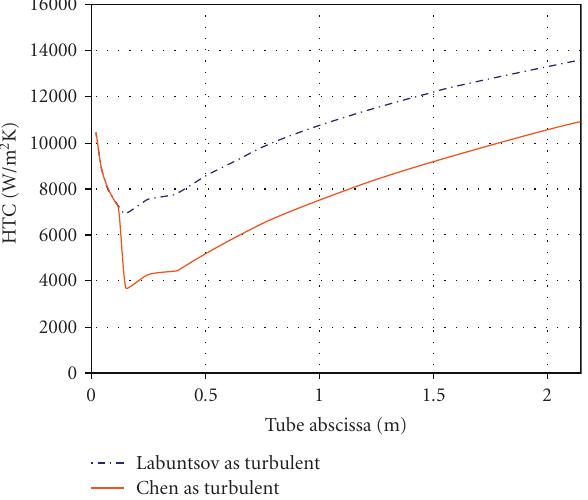
Figure 17: Condensation HTC along tube abscissa, according to film condensation theory (G = 61.5 kg/sm 2